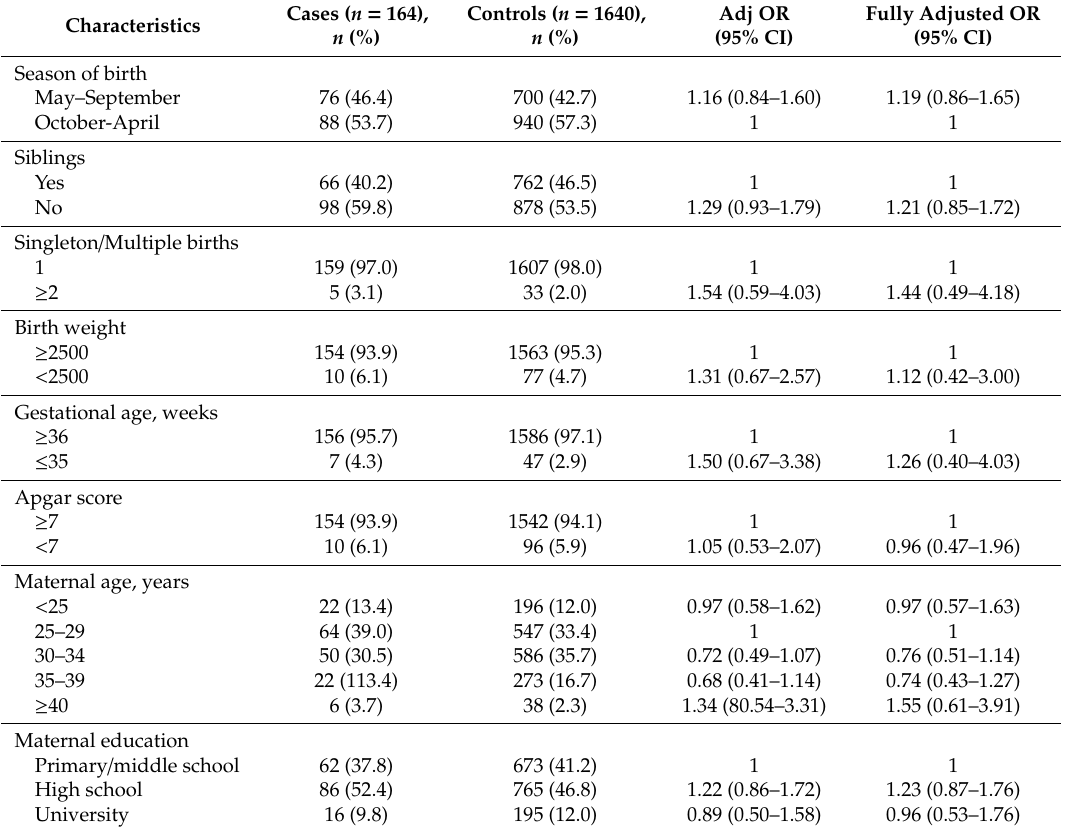
Table 2. Perinatal conditions and development of childhood onset IBD.